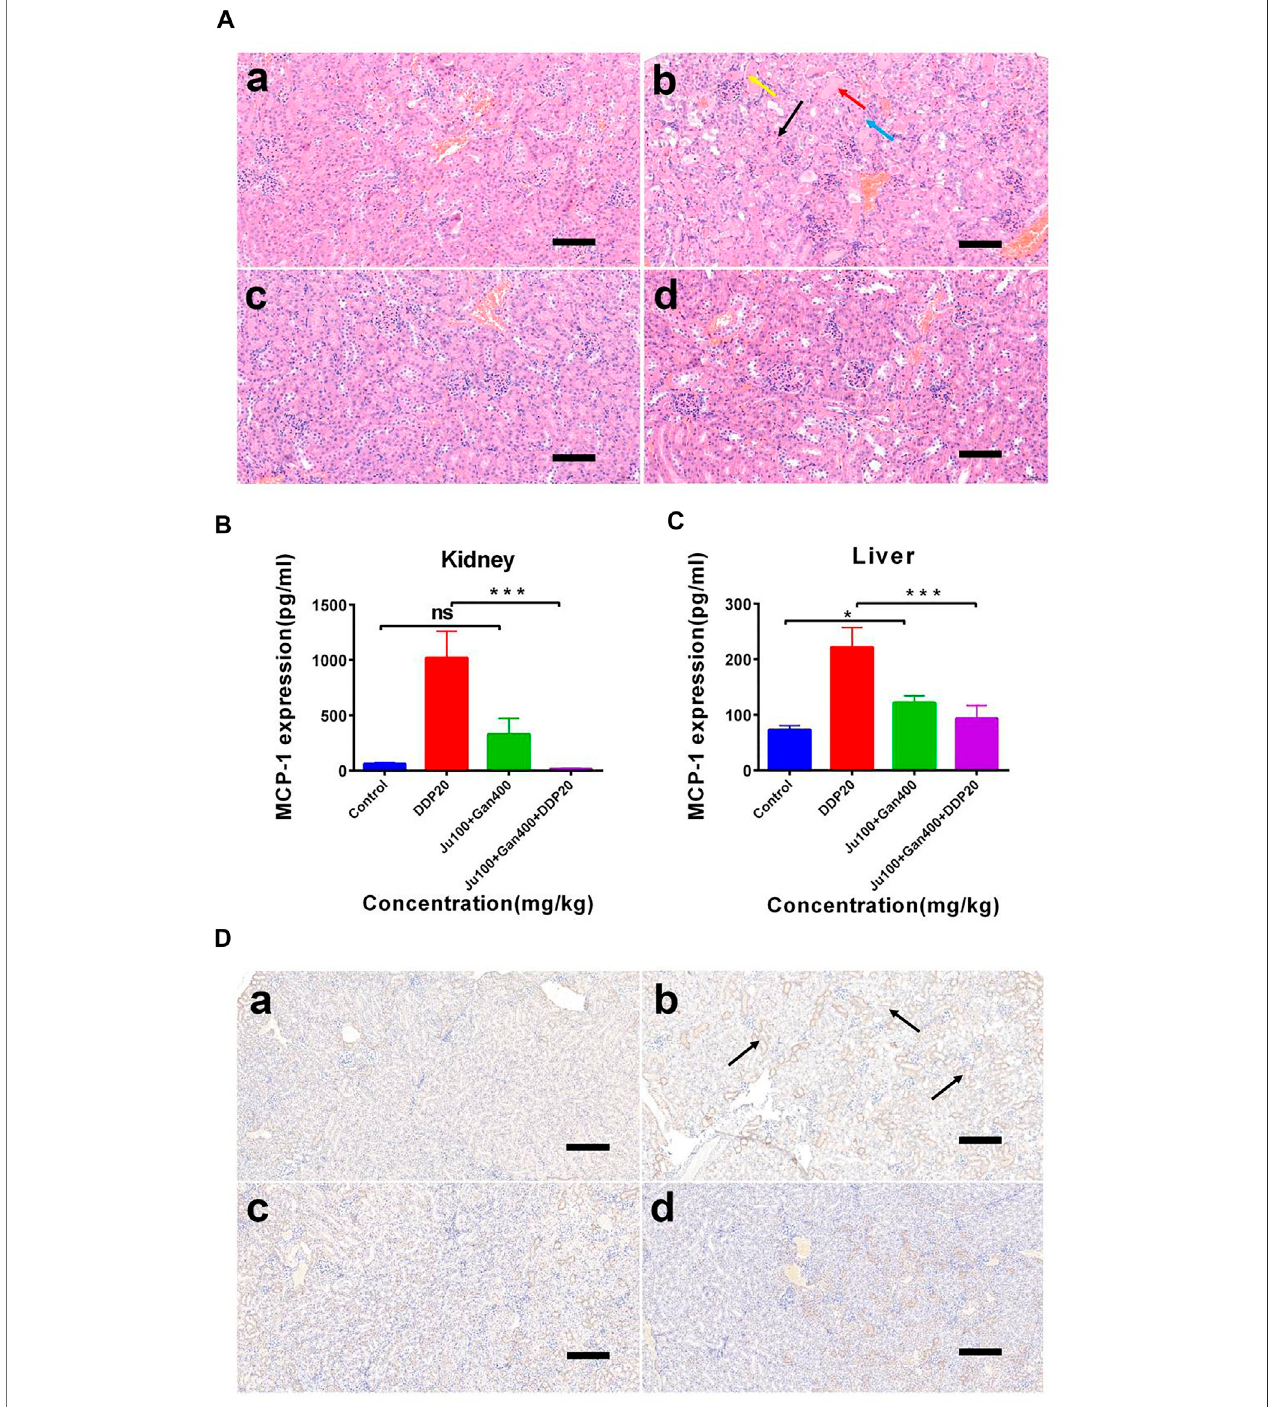
FIGURE 6 | The effect of two Chinese medicine formulas on the nephrotoxicity induced by DDP. (A) Representative neutrophil in fi ltration immunohistochemical staining in mouse kidney: (A) control; (B) DDP group; (C) Chinese medicine formulas group; and (D) DDP combined with traditional Chinese medicine formula group. Expression of MCP-1 in kidney (B) and in liver (C) . (D) Representative H&E staining of kidney sections in mice after DDP chemotherapy. (A) control; (B) DDP group; (C) Chinese medicine formulas group; and (D) DDP combined with traditional Chinese medicine formula group. Error bars are represented as mean ± SEM. The p values were determined by Student ’ s t test (* p < .05, ** p < .01, *** p < .001). Details of experimental procedures are given in Materials and Methods .